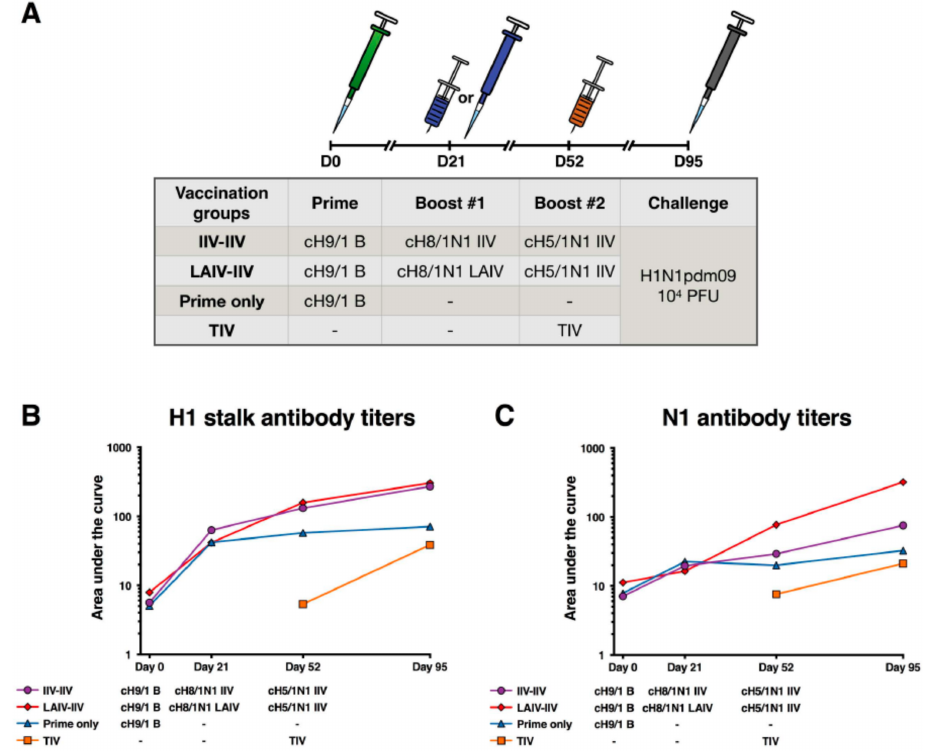
Figure 3. Vaccination strategy and antibody titers measured by ELISA. ( A ) The time line indicates the timing of the vaccinations and the viral challenge. The table shows the corresponding vaccinations for each time point. Serum antibody titer levels were measured by ELISA against the H1 stalk ( B ) and N1 ( C ). The IIV-IIV group is shown as purple circles, the LAIV-IIV group is shown as red diamonds, the prime only group is shown as blue triangles, and the TIV group is shown as orange squares. The y-axis shows the area under the curve and the x-axis shows different time points. Each point shows the geometric mean titer for four